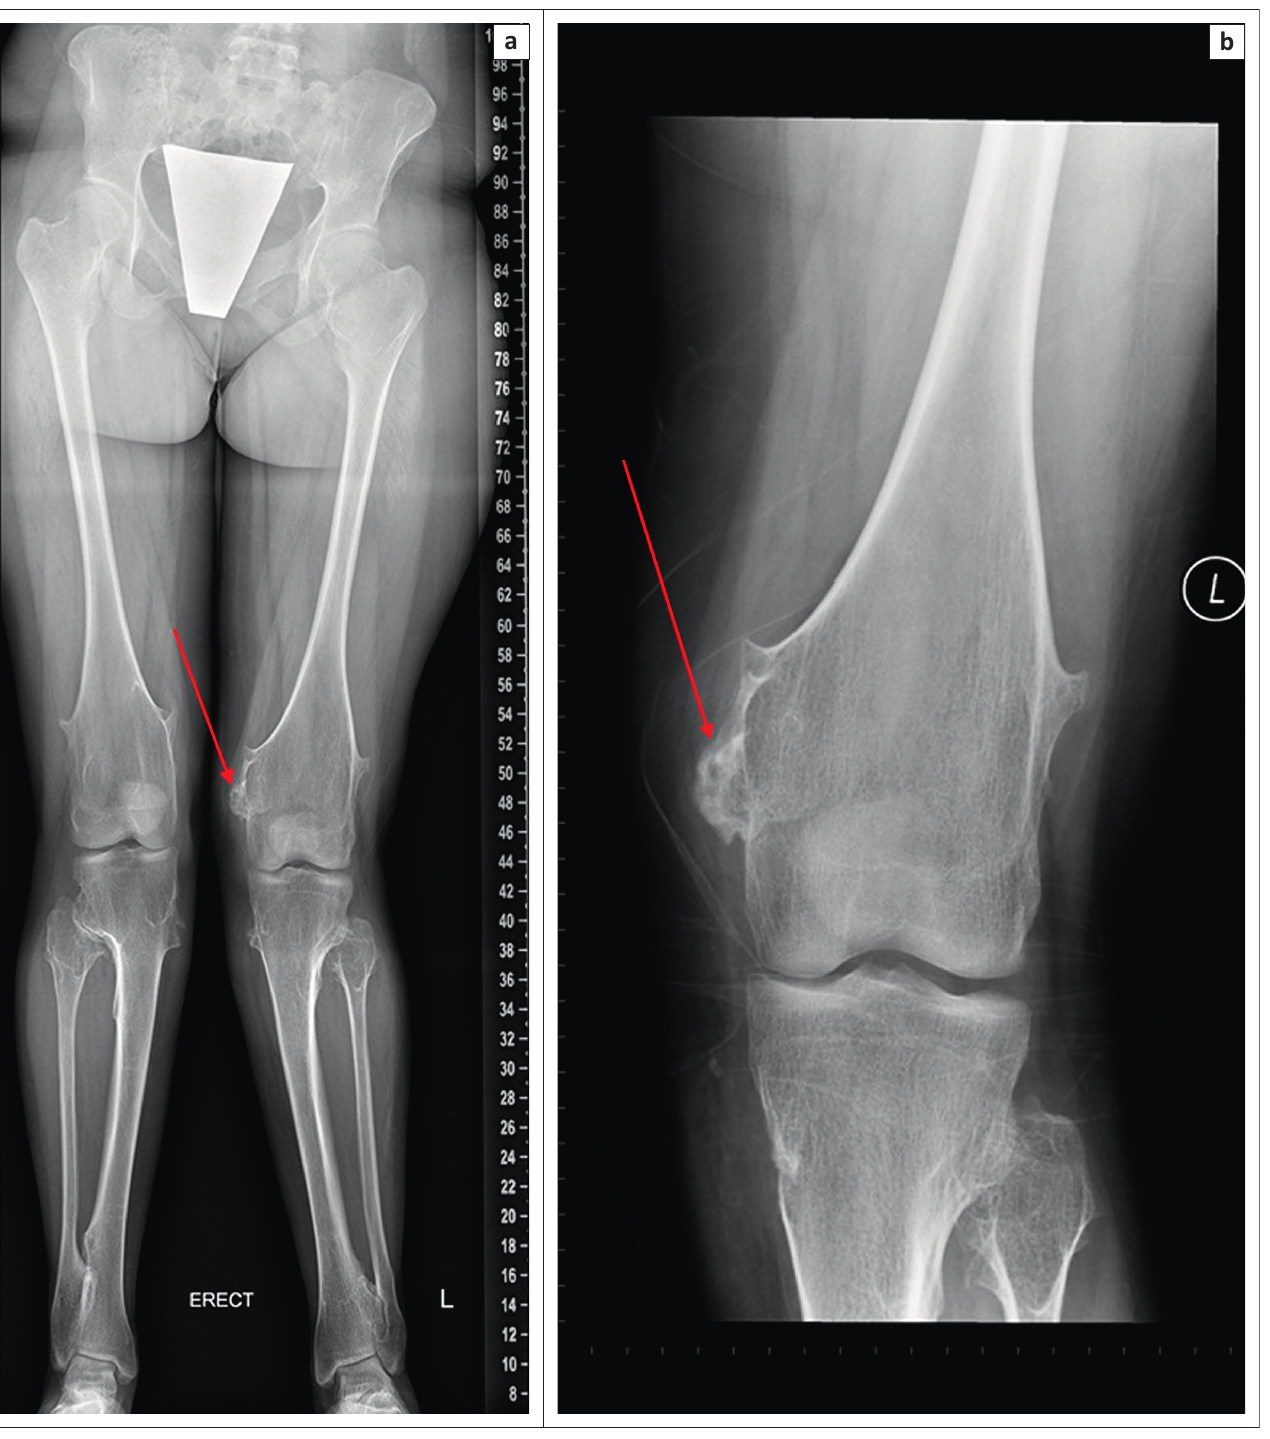
FIGURE 1: Full-length radiograph (a) of the lower extremities reveals multiple hereditary exostoses (diaphysial aclasia) with multiple exostoses of the femorae, tibiae and fibulae bilaterally, with irregular enlargement and calcification of the medial distal femoral exostosis (red arrows; image b is of a smaller field of